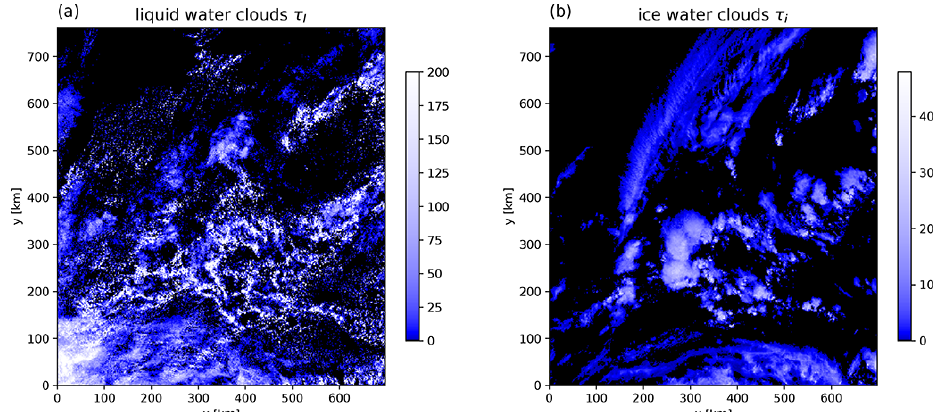
Figure 8. Vertically integrated cloud optical thickness for the simulated cloud scene from the ICON LES model: (a) liquid water clouds and (b) ice water